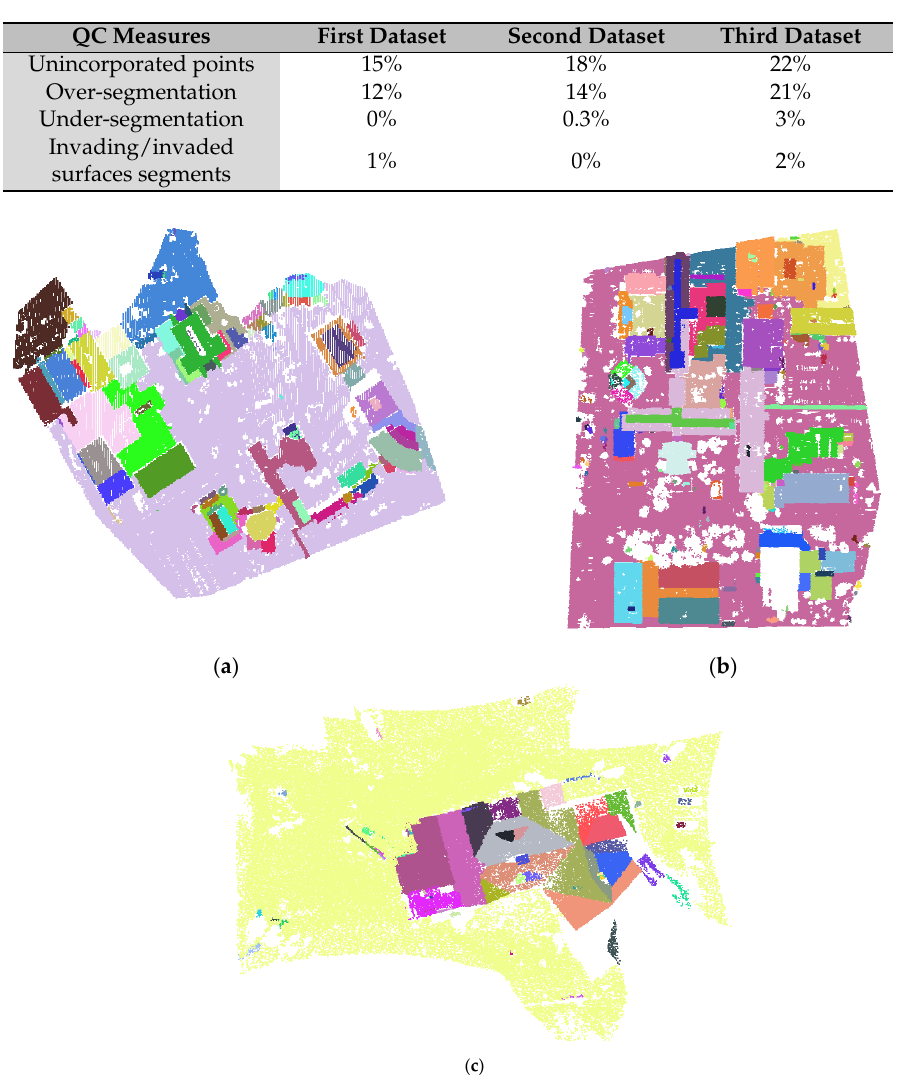
Table 4. Derived quality control measures for the planar feature segmentation results from airborne laser scanning datasets.